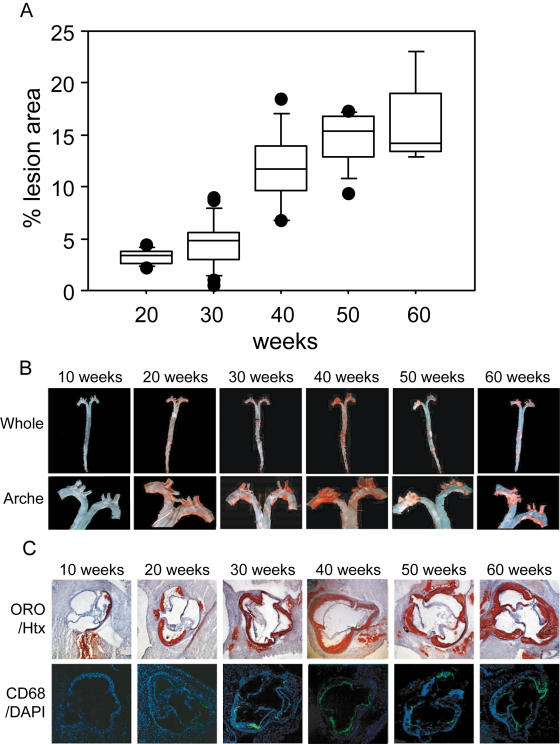
Atherosclerosis progression in Ldlr
−/−
Apob100/100 Mttp
flox/flox mice.(A) Box plots of atherosclerosis progression at 20 (n = 12), 30 (n = 25), 40 (n = 15), 50 (n = 15), and 60 weeks (n = 10). P<0.05, 20 vs. 30 weeks; P<0.0001, 30 vs. 40 weeks; P<0.02, 40 vs. 50 weeks. Values are surface lesion areas assessed by Sudan IV staining of pinned-out aortas and given as a percentage of the surface of the entire aorta. Boxes enclose values between the 75th and 25th percentiles, bars indicate values between the 90th and 10th percentiles, and black dots indicate individual observations outside these boundaries. (B) Representative aortic trees (above) and arches (below). (C) Representative sections of the aortic root were stained with Oil-red-O and counterstained with hematoxylin (Htx) or show CD68 fluorescence and counterstained with DAPI.